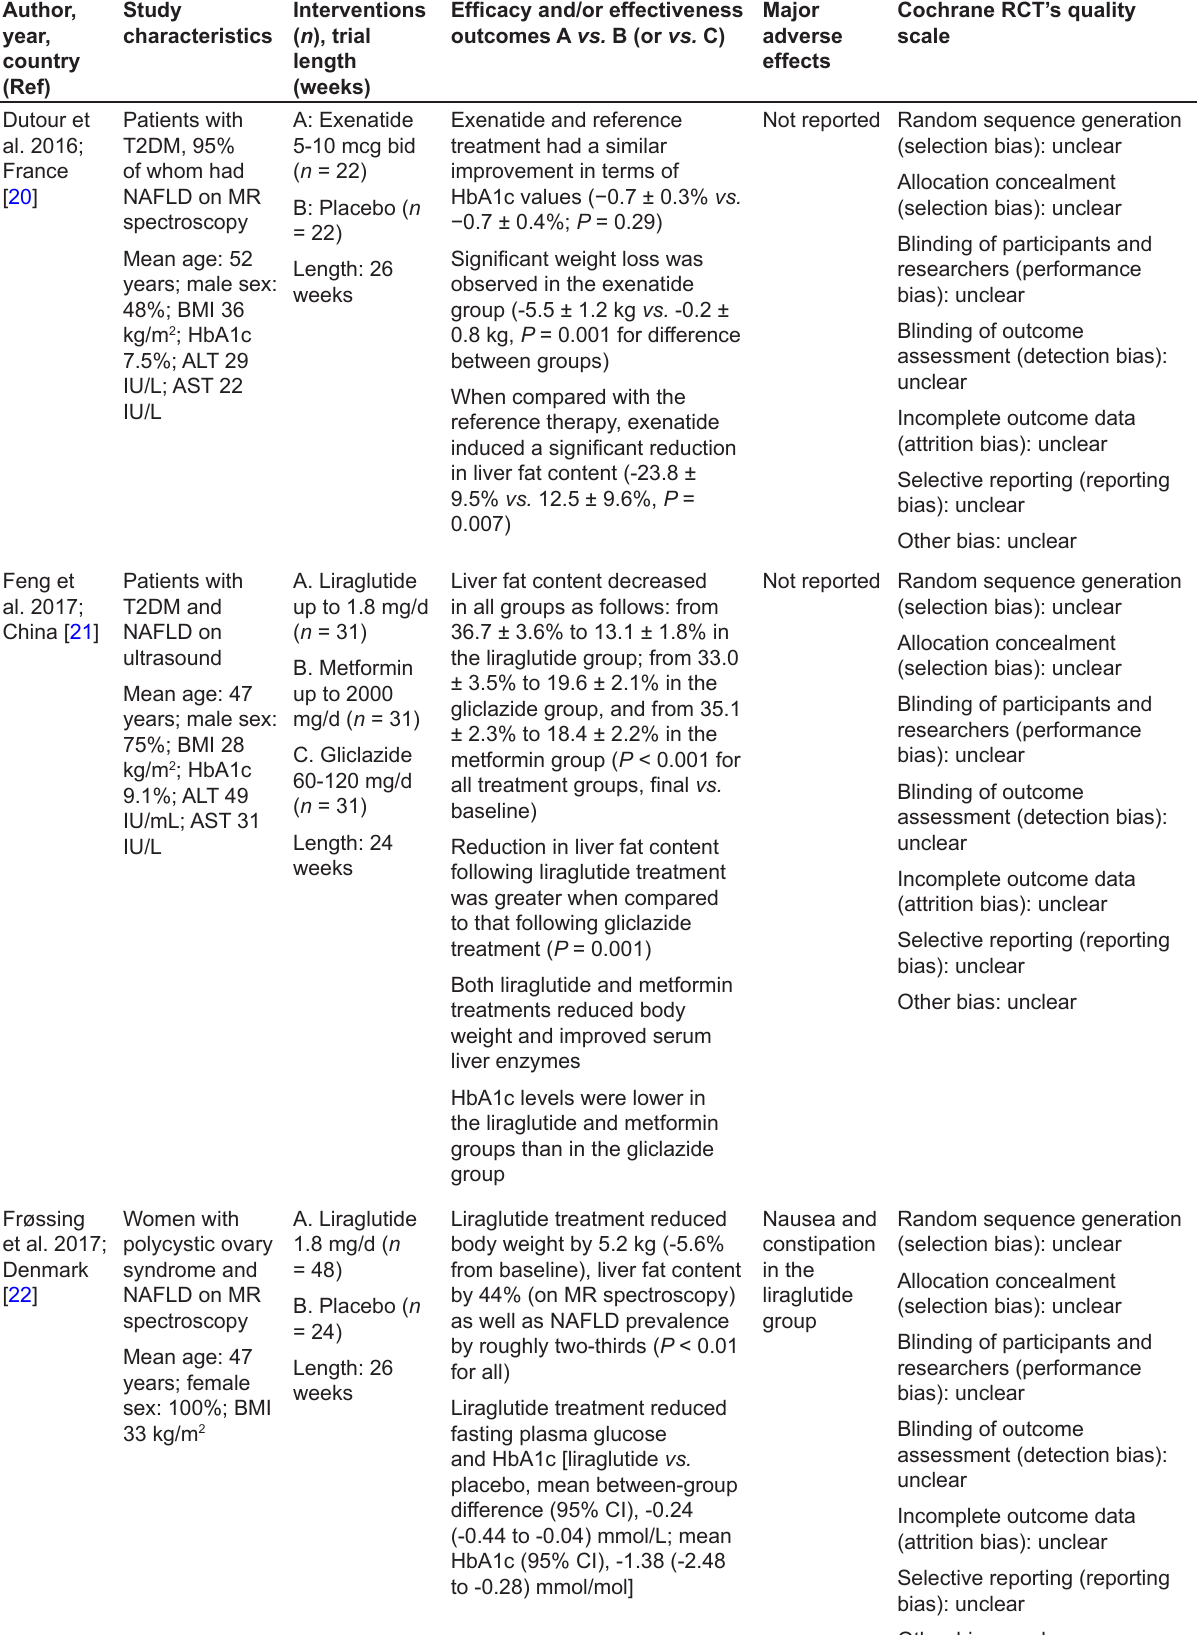
Table 1 . Placebo-controlled or active-controlled RCTs of GLP-1 RAs for treatment of NAFLD or NASH (ordered by publication year) ( continued ) outcomes A vs. B (or vs.